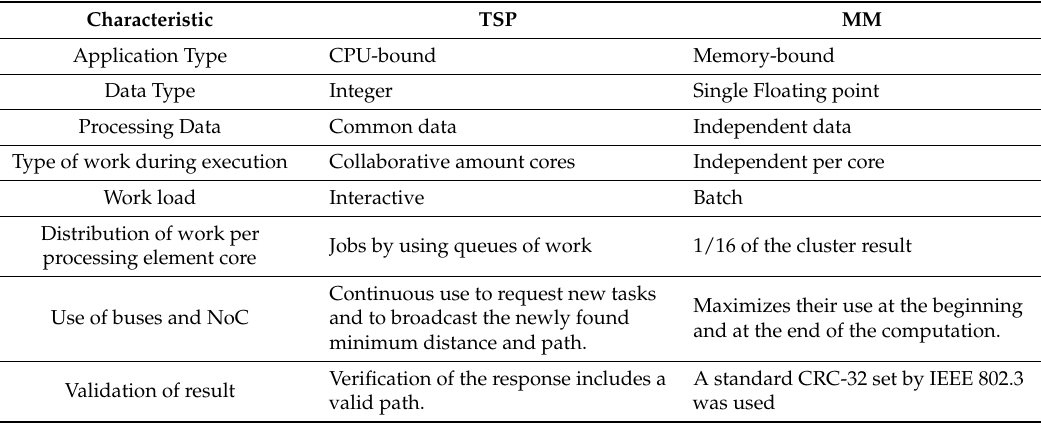
Table 2. Benchmark applications characteristics.